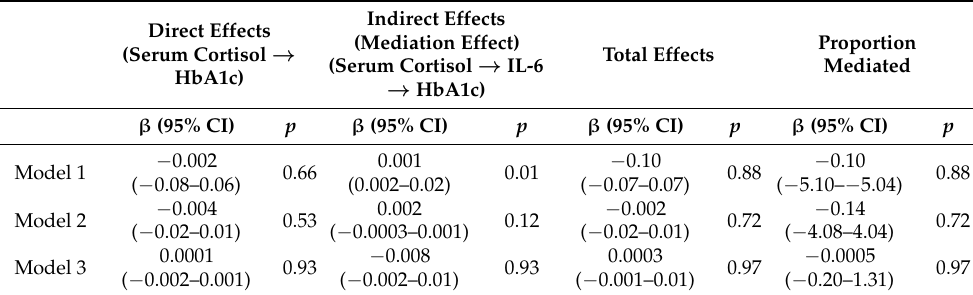
Table A2. Standardized effects of serum cortisol measures on HbA1c via IL-6 as mediator, in age and sex adjusted models (Estimate, 95% CI, p -value).